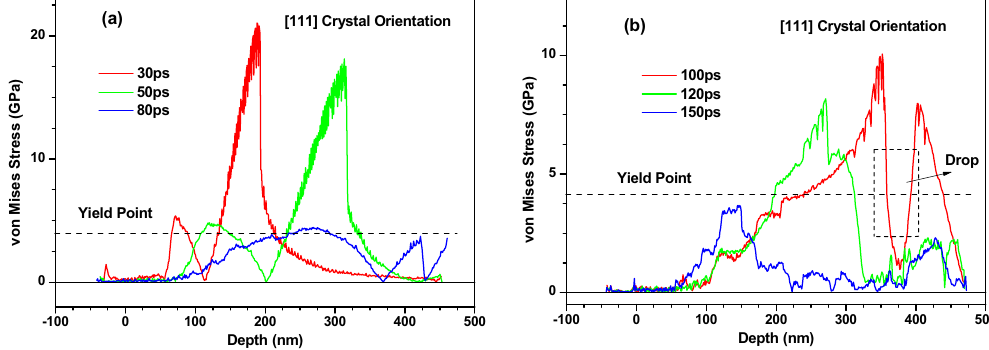
Figure 16. Equivalent stress (von Mises) distribution of 450 nm 〈 111 〉 copper films under an absorbed laser intensity of 0.065 J/cm 2 at 30–150 ps time